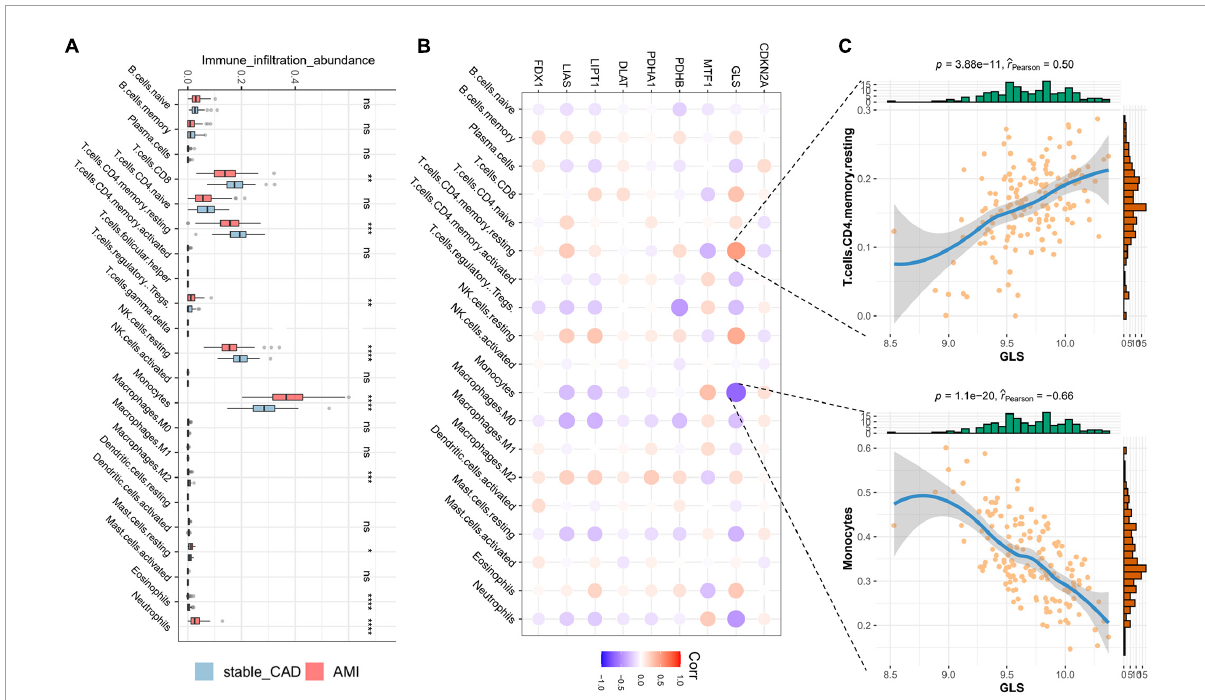
FIGURE4 Landscape of immune cells and the correlation degree between cuproptosis-related genes (CRGs) and immune cells. (A) The boxplot of differential expression of immune cells in AMI (stable_CAD: stable coronary heart disease, AMI: acute myocardial infarction). (B) The heatmap of the correlation degree between CRGs and immune cells (the darker the color and the larger the graph, the more relevant it is. Red is positive, and purple is negative). (C) Correlation between GLS and T cells. CD4 memory resting as well as monocytes. * P < 0.05, ** P < 0.01, *** P < 0.001, **** P <